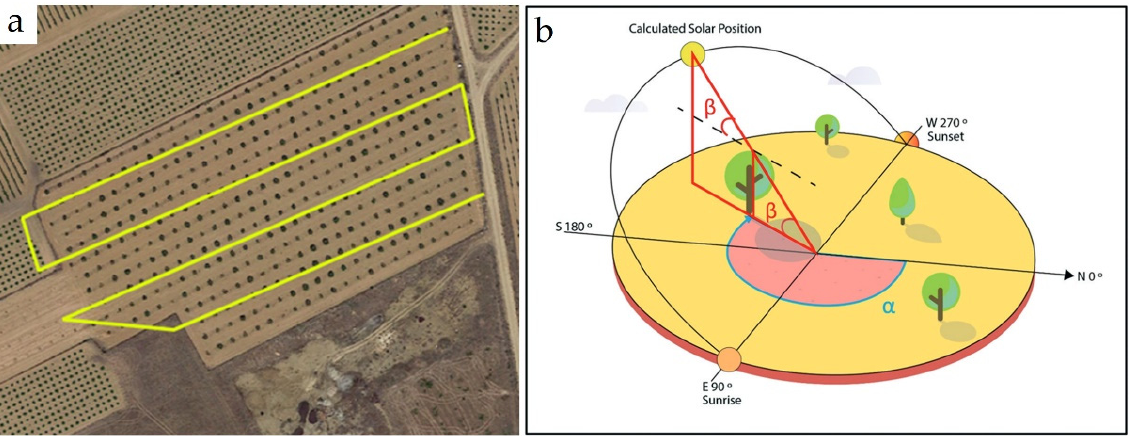
Figure 6. ( a ) Planned flight mission. Yellow line: unmanned aerial vehicle (UAV) path. ( b ) Azimuth and relationship between sun elevation and shadows, adapted from Vélez et al. [37].